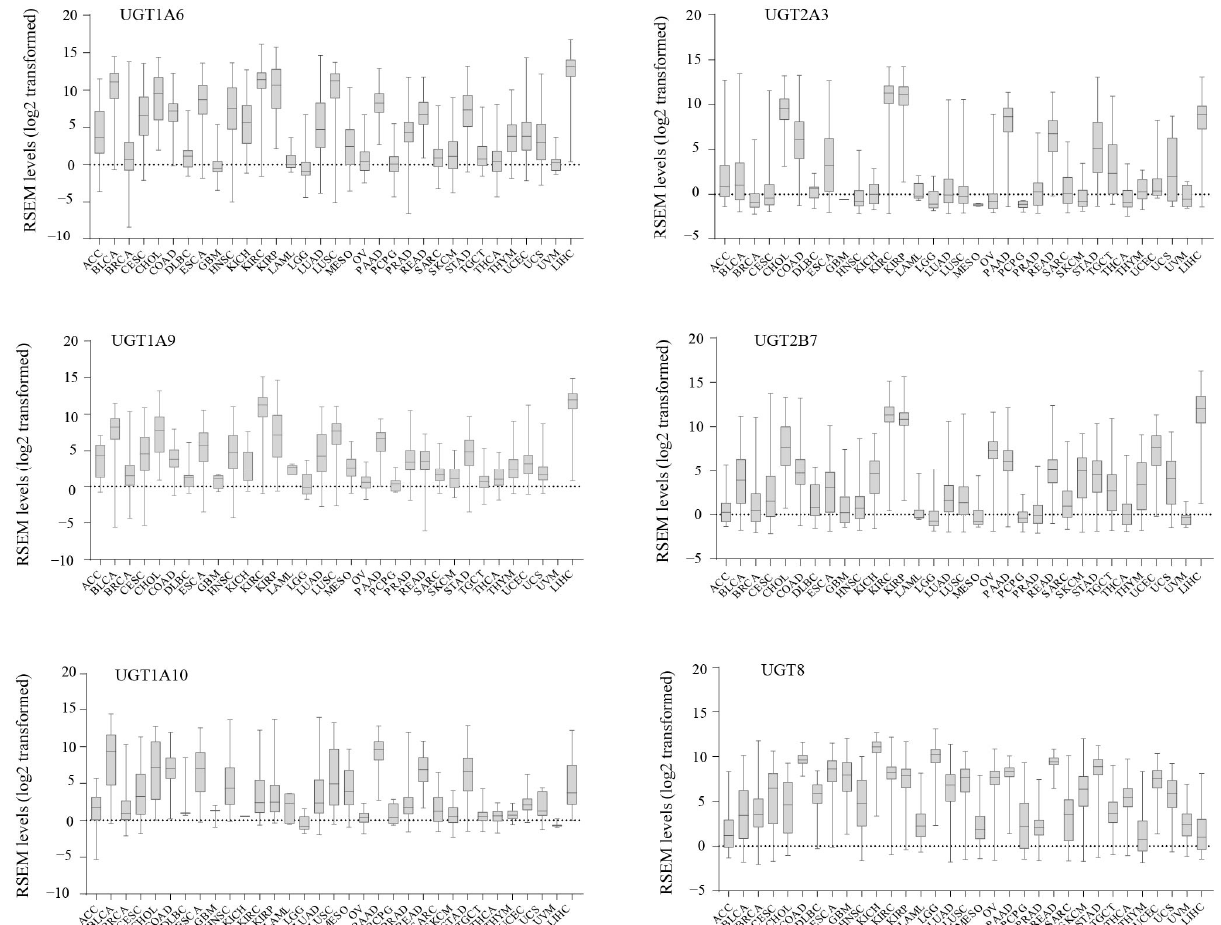
Figure 2. The expression profiles of 6 UGT genes ( 1A6 , 1A9 , 1A10 , 2A3 , 2B7 , UGT8 ) in 33 different types of TCGA cancers. The log2-transformed expression levels (RSEM values) of 6 UGT genes in 33 TCGA cancer types as indicated at the X-Axis are presented using the box-and-whisker plots that show the distribution of the expression levels (minimum, first quartile, median, third quartile, and maximum) in each of these cancers.